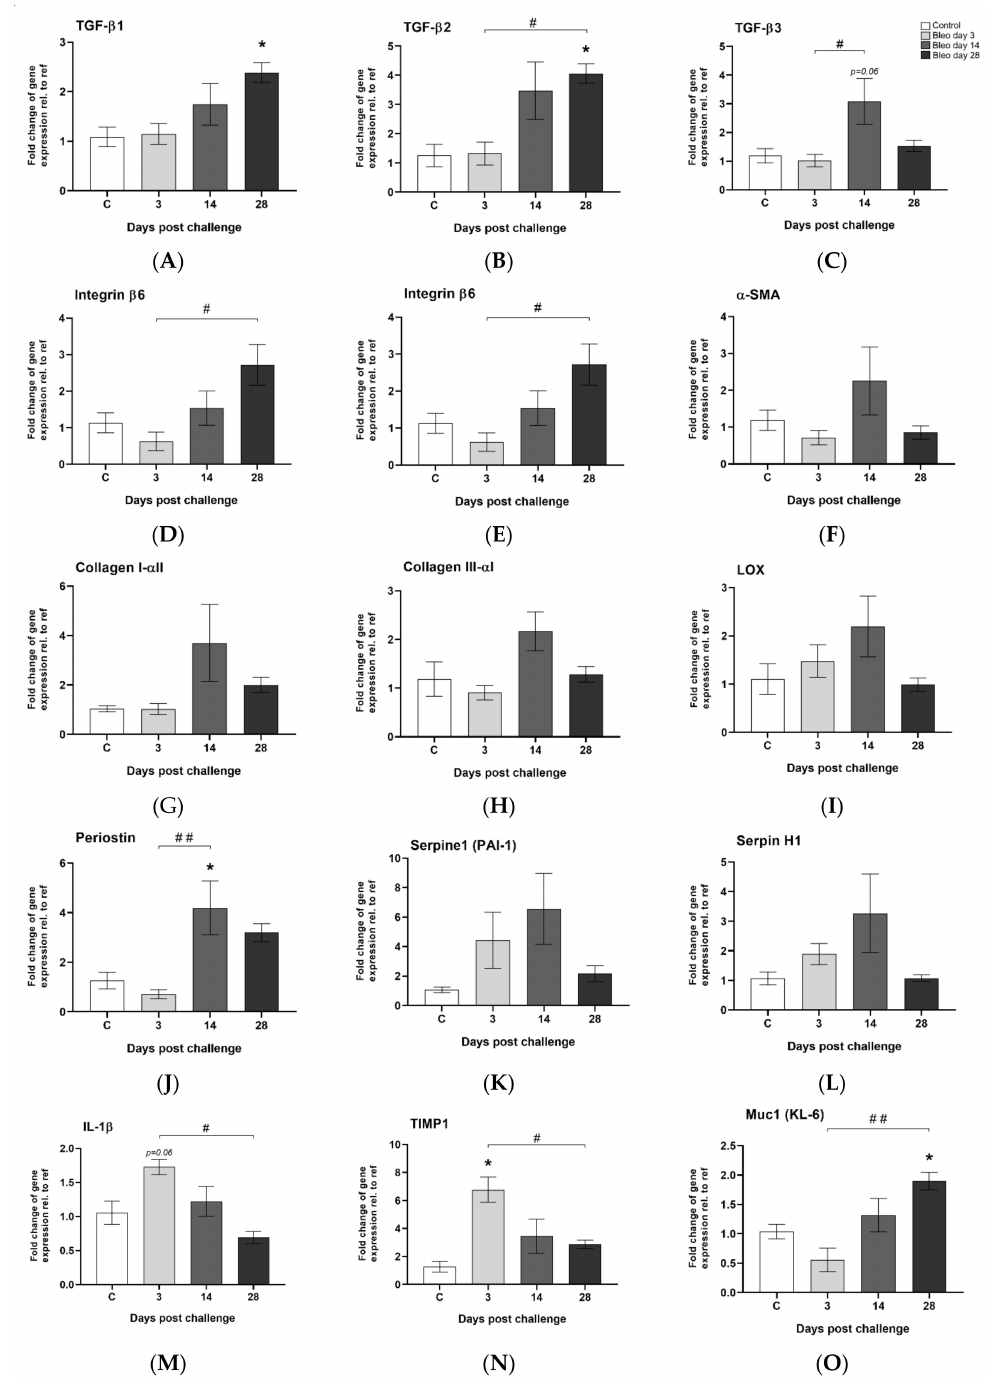
Figure 6. Gene expression of markers involved in lung injury and wound healing. ( A ) TGF- β I, ( B ) TGF- β II, and ( C ) TGF- β III were induced at later time points, similar as ( D ) integrin β 6. The fibrosis-associated genes ( E ) gremlin1 and ( F ) α -SMA were both mainly induced at day 14. The same appeared for ( G ) collagen-I and ( H ) collagen-III, ( I ) LOX, ( J ) periostin, ( K ) serpine1, and ( L ) serpineH1. Inflammatory-associated ( M ) IL-1 β was not expressed at late time points. ( N ) TIMP1 gene expression was induced early during the first days of the model, while ( O ) the muc1 gene was significantly upregulated with time and peaked at day 28. All data are presented as mean ± standard error of the mean (SEM). All samples from the bleomycin group are related to the mean of control and normalized to the geometric mean of two di ff erent reference genes. Each presented group / time point contains n =